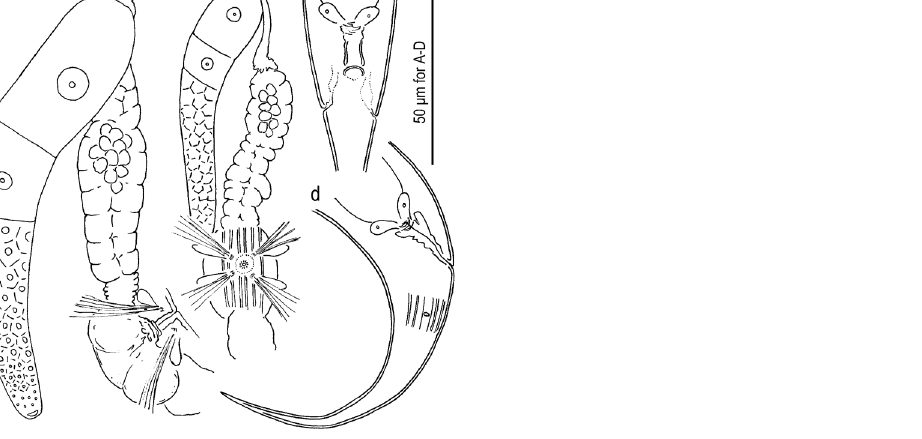
Figure 4. Adult female of Onthodiplogaster japonica n. gen., n. sp. ( a ) Anterior gonad in right lateral view; ( b ) anterior gonad in ventral view; ( c ) anal region in ventral view; ( d ) entire tail in right lateral view showing body surface structure in phasmid